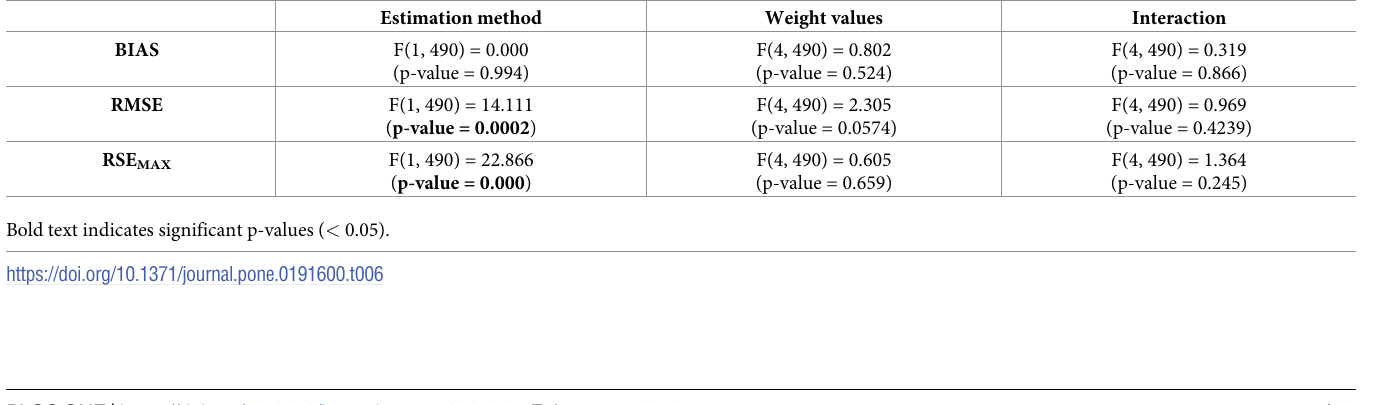
Table 6. Two-way ANOVA using data generated in scenario